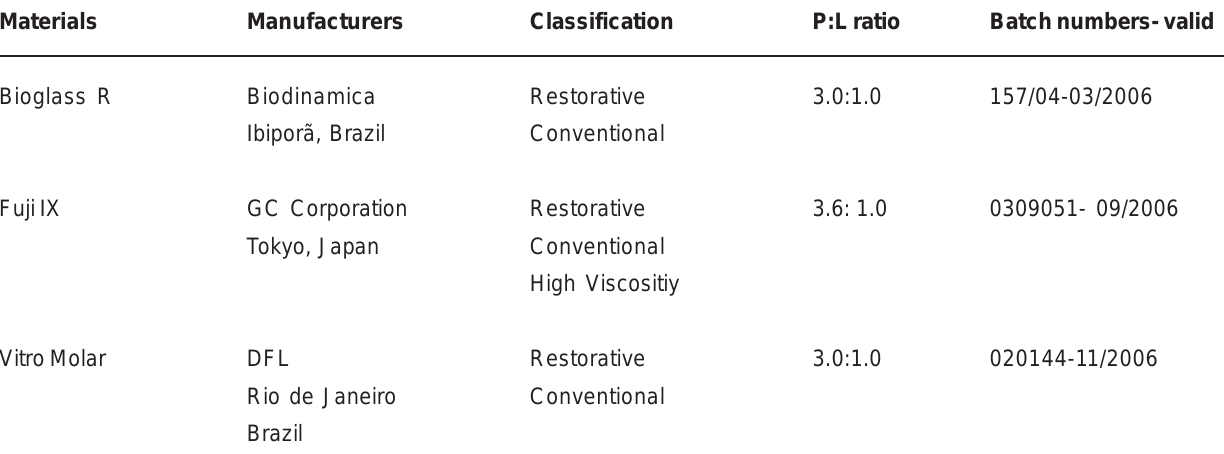
TABLE 1- Materials, manufacturers, GIC classification, powder:liquid (P:L) ratio, and batch numbers Materials